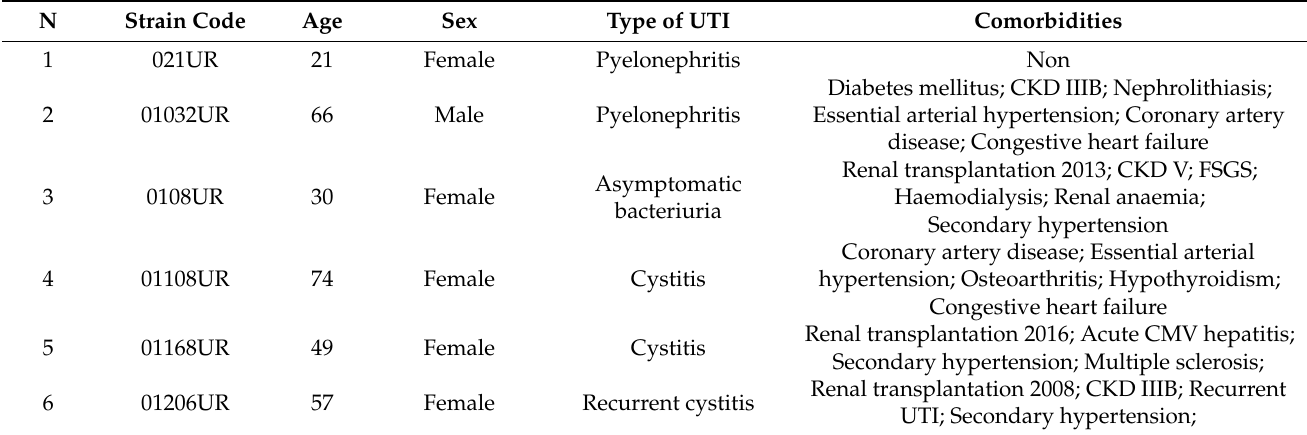
Table 1. Patient characteristics for isolated bacterial strains. CKD, chronic kidney disease; FSGS, focal